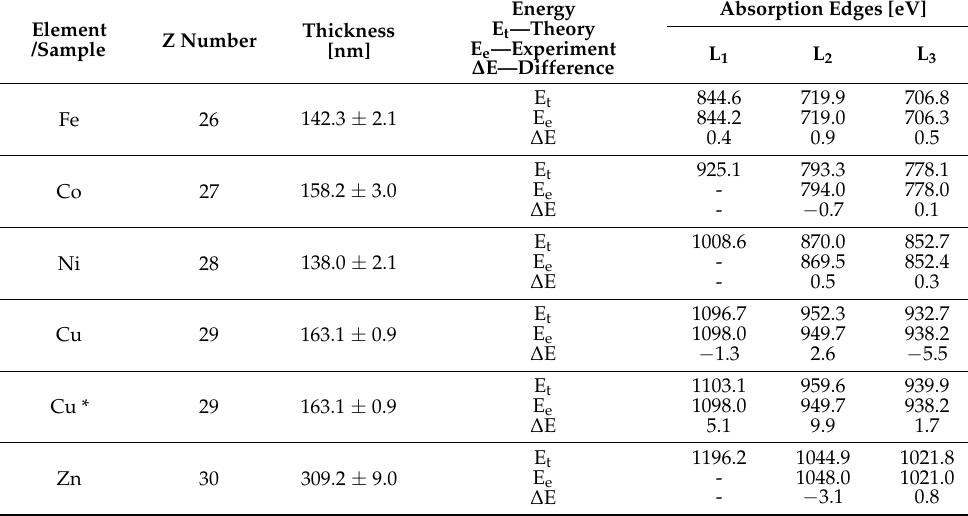
Table 1. List of transition metals deposited on top of 100 nm thick SiN membranes as single layers, as well as the results of L 1 –L 3 edge NEXAFS energies: theoretical (E t ), based on [49], and experimental values (E e ). Some of the edges were not detected in this experiment. Experimentally obtained edge energies are slightly shifted compared to theoretical energies for bulk materials, as described by the ∆ E parameter, where ∆ E = E t − E e